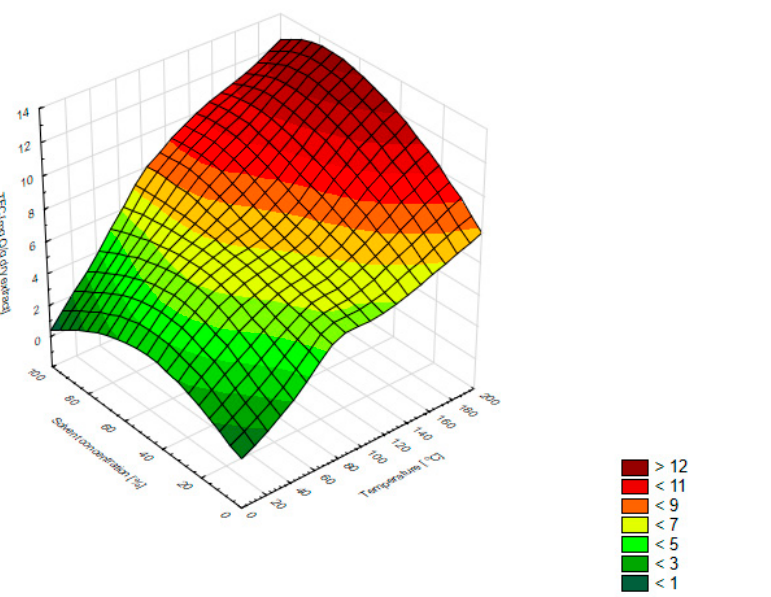
Figure 2. Three-dimensional surface chart of the total flavonoid content vs. temperature and solvent concentrations for all extraction methods (smoothing of the smallest squares weighted by distance). Table 2. Pearson’s correlation coefficients ( r ) between different extraction conditions, efficiency of extraction (EEx), total phenolic content (TPC), total flavonoid content (TFC), and antioxidant